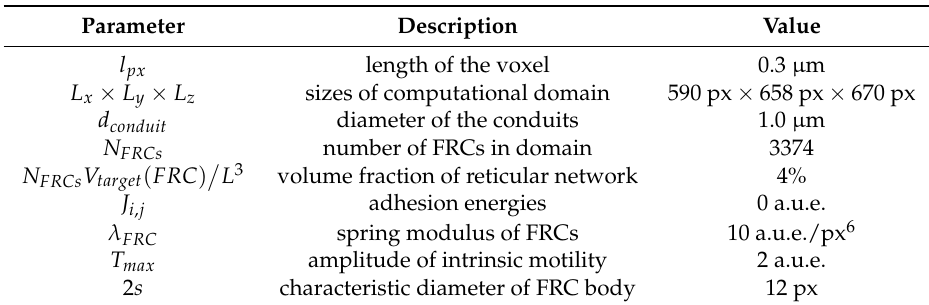
Figure 1. ( a ) The initialized reticular network as the system of conduits of given topology. State of the simulation at MCS = 0; ( b ) The reticular network reached its target volume. State of the simulation at MCS = 20. Table 1. Parameters of Cellular Potts Model used to generate the reticular network (a.u.e. stands for arbitrary units of